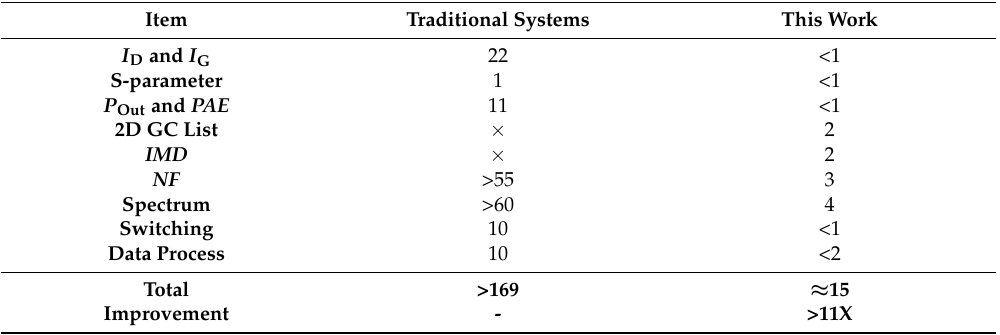
Table 8. Measurement speed comparison (in